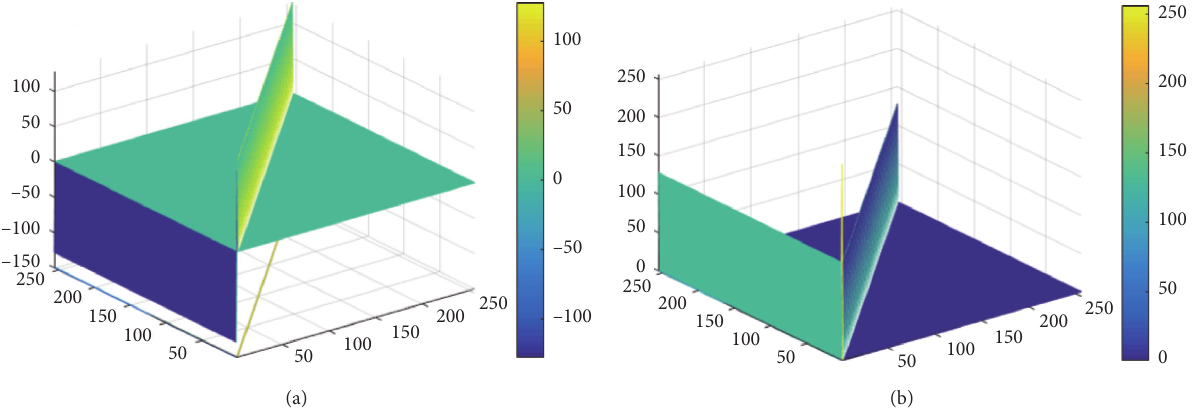
Figure 3: Three-dimensional maps of the matrices (a) n